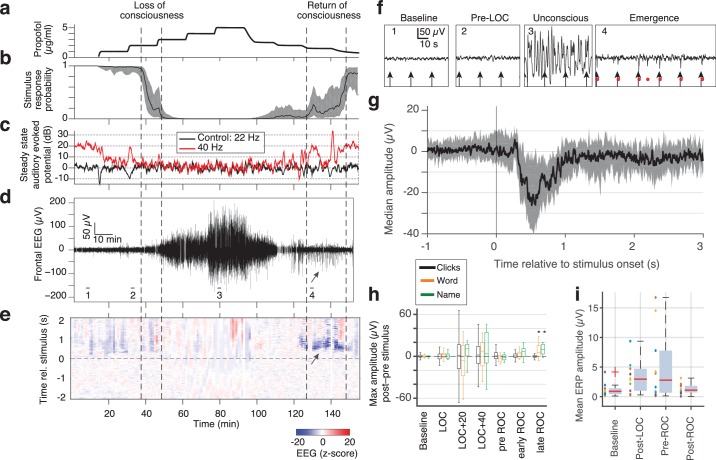
Large evoked potentials can be detected during emergence in scalp EEG recordings.(A) Experimental design for scalp EEG volunteer study: target propofol plasma concentration increased and decreased as a controlled step function. (B) Behavioural response rate in one subject shows times of loss of consciousness (LOC) and recovery of consciousness (ROC). (C) Steady state auditory evoked potential (SSAEP) at lateral electrodes to the click train stimulus (repetition rate 40 Hz, red) declines during propofol general anesthesia; the control frequency (22 Hz) shows no SSAEP. (D) EEG at a central electrode over the entire recording shows high-amplitude, low-frequency power during the anesthetized period. Prior to ROC (around 120 min, marker 4), large unipolar negative potentials are observed (arrow). (E) Stimulus-triggered average exhibits large, slow potentials prior to return to the awake state, but not during induction or during maintenance. (F) Example records from the epochs marked in panel D show that sensory-evoked LPs in the scalp EEG occur during emergence (4), but not pre-anesthesia baseline (1), pre-LOC (2) or profound unconsciousness (3). (G) Median of events in a central channel occurring during ROC following click stimuli. Shaded region is interquartile range. (H) Timecourse of ERP amplitudes in the same individual subject: boxplot indicates variability of mean ERP amplitude across individual trials. LPs selectively appear during emergence, and are evoked by the infrequent word and name stimuli (orange, green), but not by the frequent noise bursts (black). Stars indicate significance at p<0.01 with Wilcoxon signed-rank test. This subject exhibits a slow emergence with LPs appearing around and after the initial onset of ROC. (I) Boxplot of absolute value of mean ERP amplitude across all subjects estimated within 5 min windows during each epoch. Colored points show individual subjects.10.7554/eLife.33250.011Figure 4—source data 1.Mean ERP for each EEG subject (baseline).10.7554/eLife.33250.012Figure 4—source data 2.Mean ERP for each EEG subject (post LOC).10.7554/eLife.33250.013Figure 4—source data 3.Mean ERP for each EEG subject (post ROC).10.7554/eLife.33250.014Figure 4—source data 4.Mean ERP for each EEG subject (pre ROC).